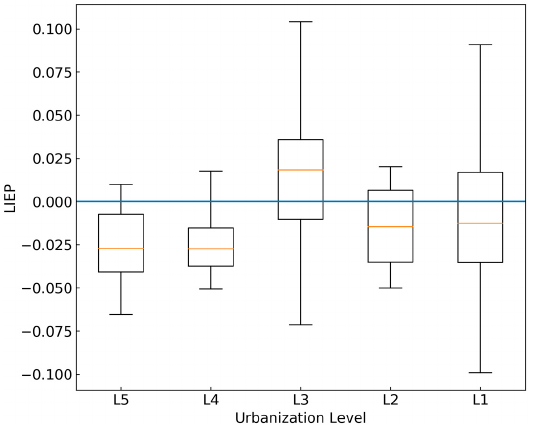
ff erent urbanization level Figure 6. The LIEP in different urbanization level areas. Figure 6. The LIEP in di